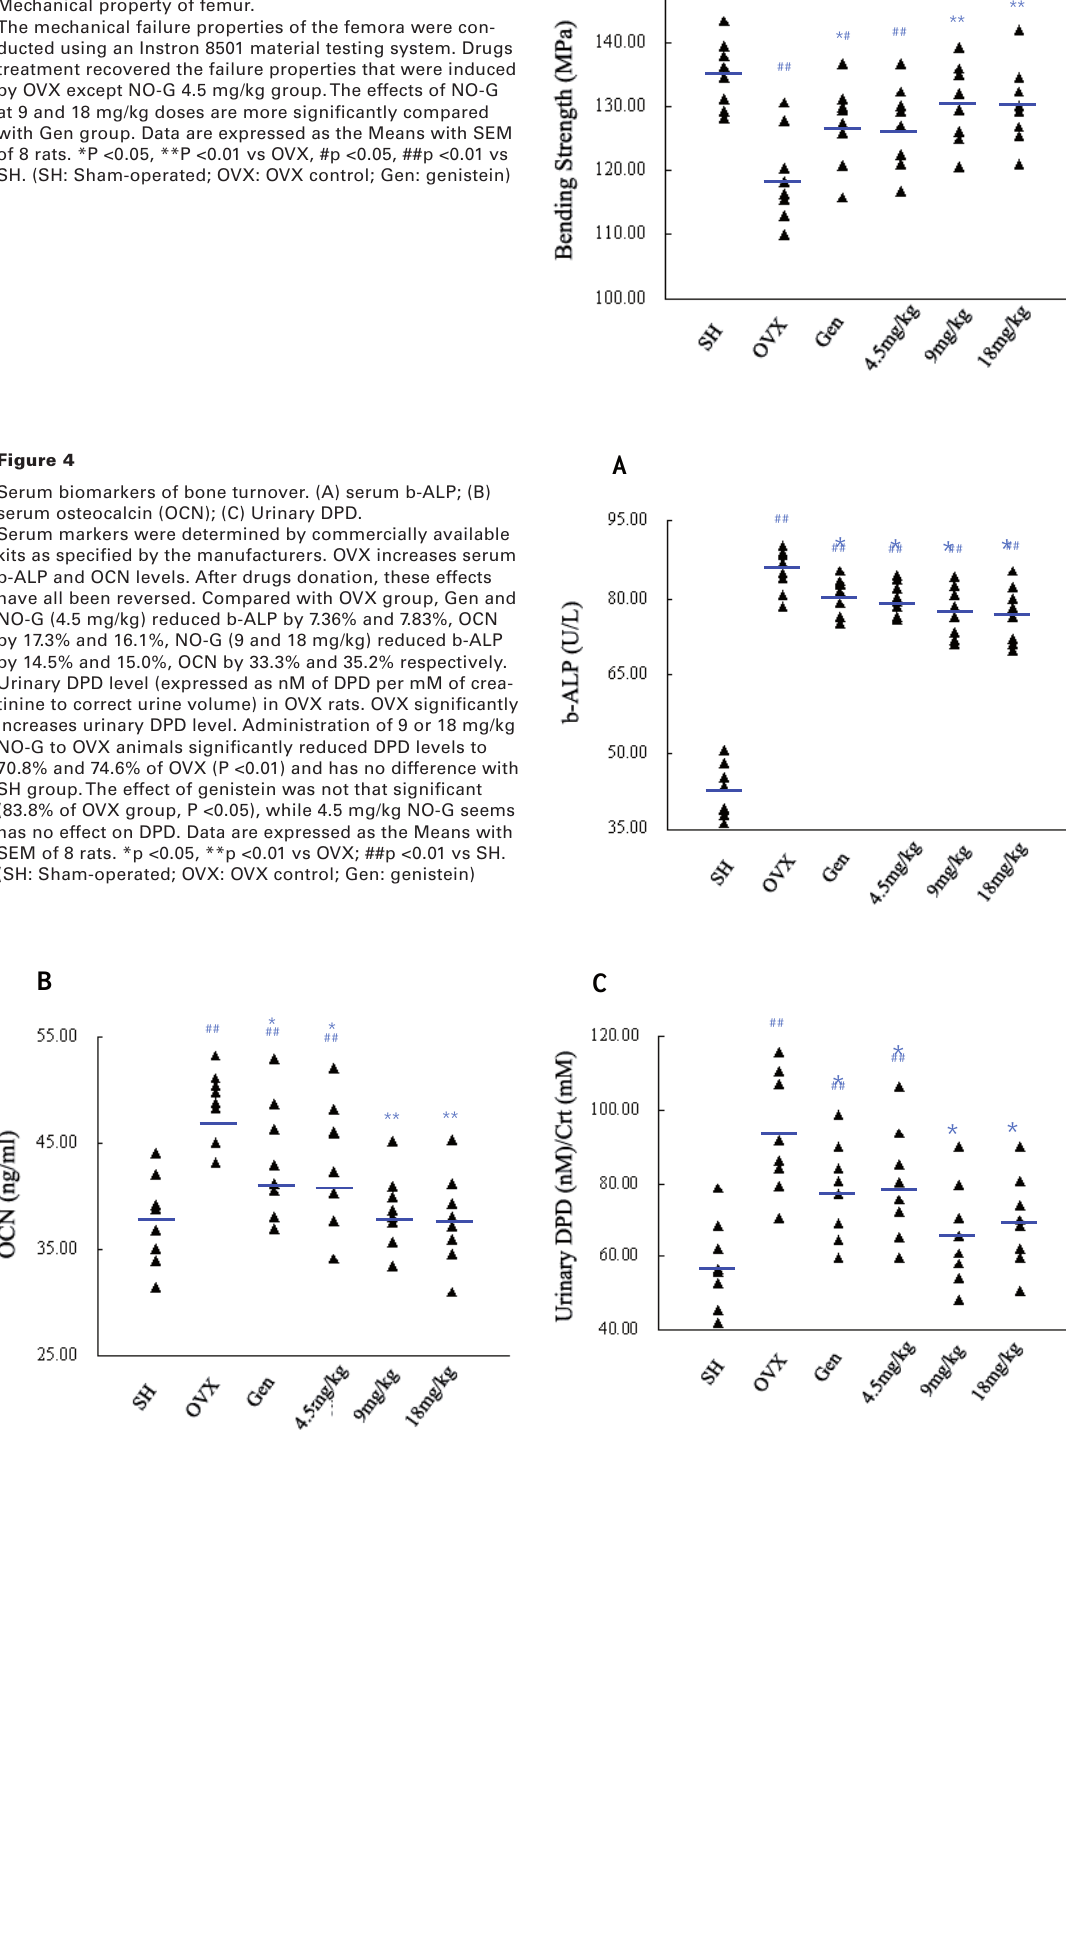
Mechanical property of femur. The mechanical failure properties of the femora were con- ducted using an Instron 8501 material testing system. Drugs treatment recovered the failure properties that were induced by OVX except NO-G 4.5 mg/kg group. The effects of NO-G at 9 and 18 mg/kg doses are more significantly compared with Gen group. Data are expressed as the Means with SEM of 8 rats. *P <0.05, **P <0.01 vs OVX, #p <0.05, ##p <0.01 vs SH. (SH: Sham-operated; OVX: OVX control; Gen: genistein)